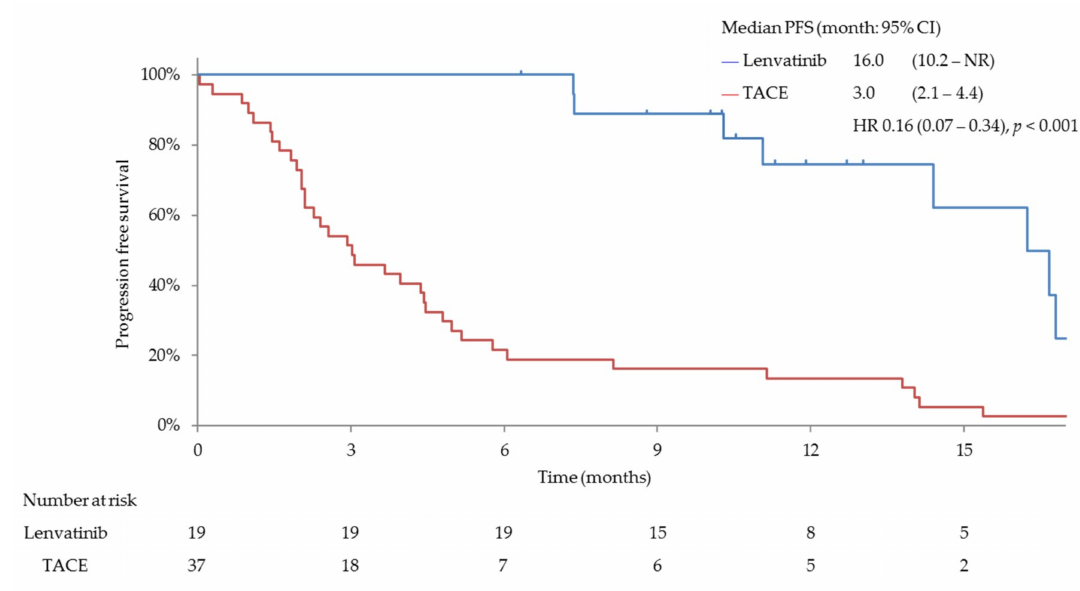
Figure A2. Progression free survival (PFS) in both groups with ALBI grade 1 liver function after propensity score matching. PFS in the lenvatinib-treated group was significantly better than that in the TACE-treated group (16.0 months vs. 3.0 months; HR 0.16, p < 0.001). NR; not